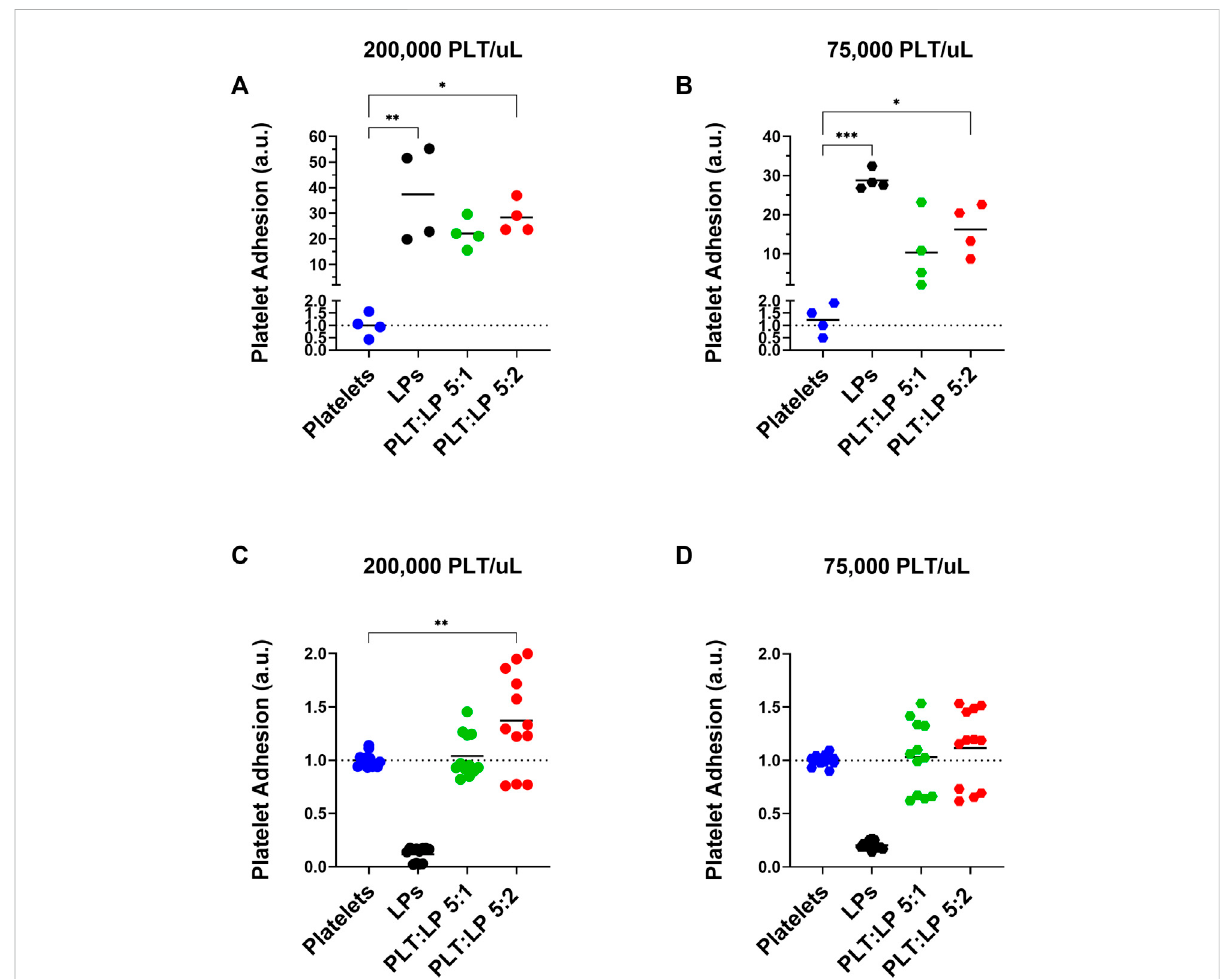
FIGURE 4 Adhesion of Platelets Mixed with Lyophilized Platelets on a Collagen Surface. Normalized quanti fi cation of the adhesion of platelets in comparison to platelets mixed with LPs (at ratios of 5:1 and 5:2 platelets to LPs) in static conditions using and LDH assay (A,B) and under fl ow using calcein AM live-cell staining (C,D) . Both assays were conducted at a (A,C) normal platelet concentration of 200,000 platelets/uL [Static: donors = 2, n = 4, Flow: donors = 3, n = 12], and a (B,D) thrombocytopenic platelet concentration of 75,000 platelets/uL [Static: donors = 2, n = 4, Flow: donors = 3, n = 12]. Note that the calcein AM live-cell staining (C,D) does not stain the inert LPs and thus the LP only condition does not represent their adhesion and is used as a control to ensure that there is no off target